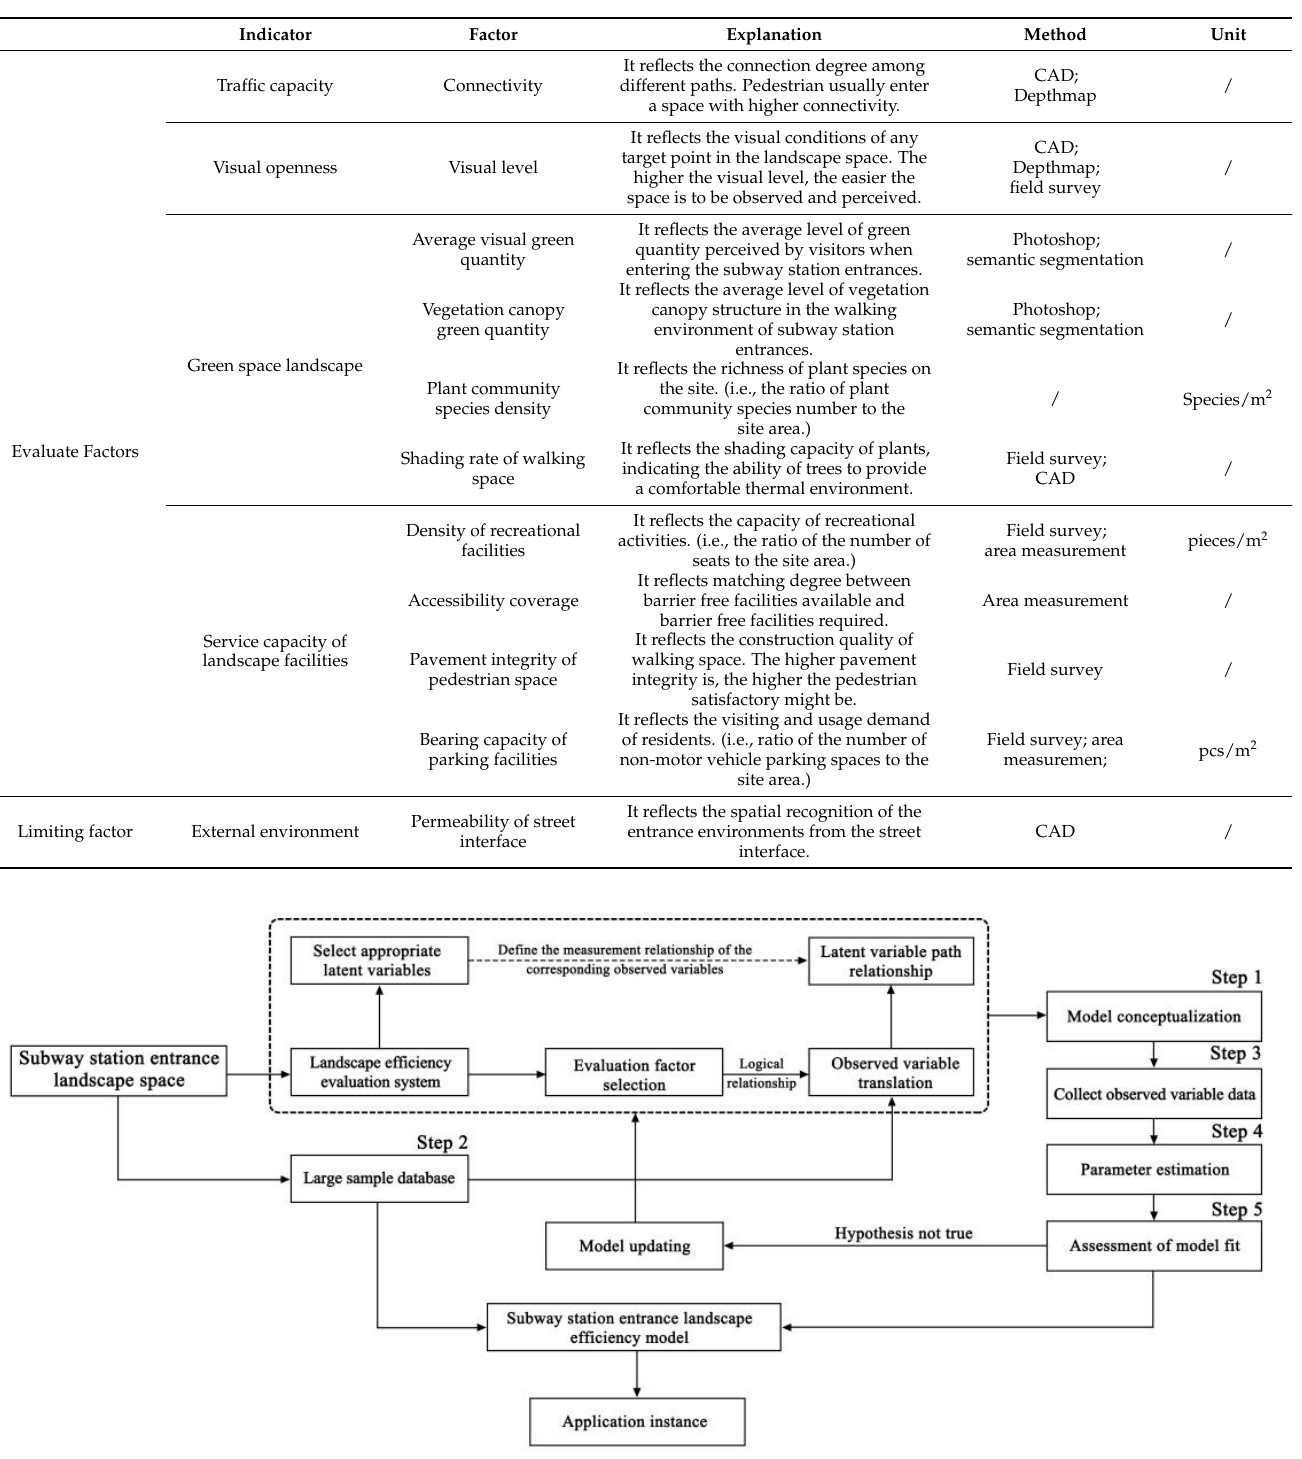
Figure 1. Steps of constructing landscape efficiency evaluation